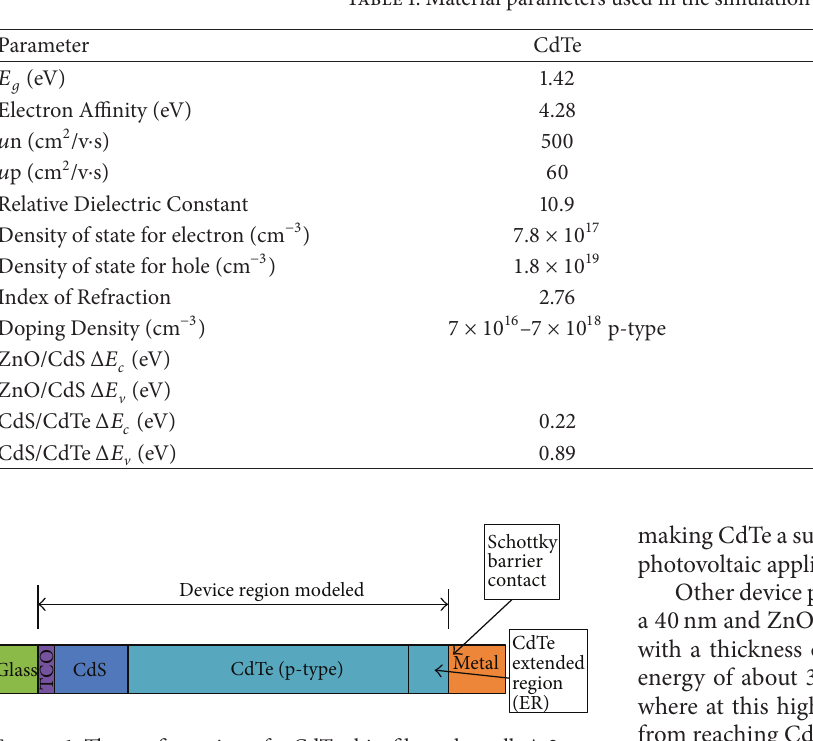
Table 1: Material parameters used in the simulation [10–12].